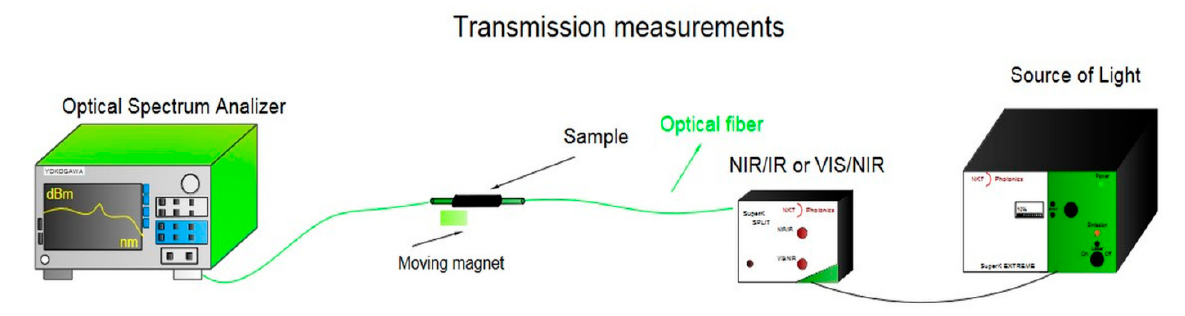
Figure 8. The arrangement for measuring the transmission of a magnetic sensor in the broadband range of 500 nm—2000 nm.